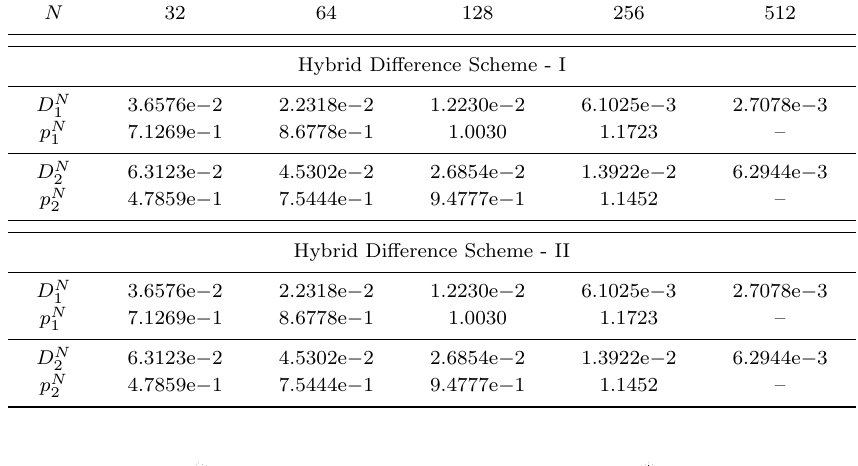
,p N and D N ,p N for the Example 1 in the coarse mesh region. 1 1 2 2